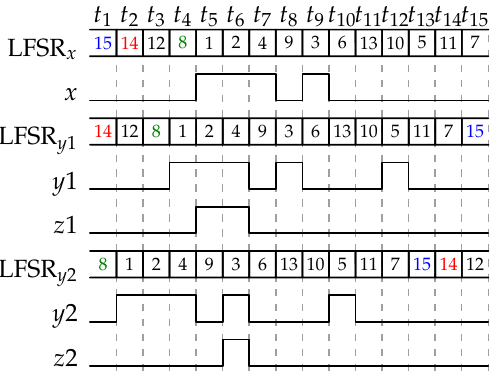
Figure 3. Impact of seeding for stochastic multiplication ( x × y , where x = 4/15 and y = 5/15). Depending on the seed used to generate the stochastic BS ( y 1 or y 2 ), different results are produced ( z 1 or z 2